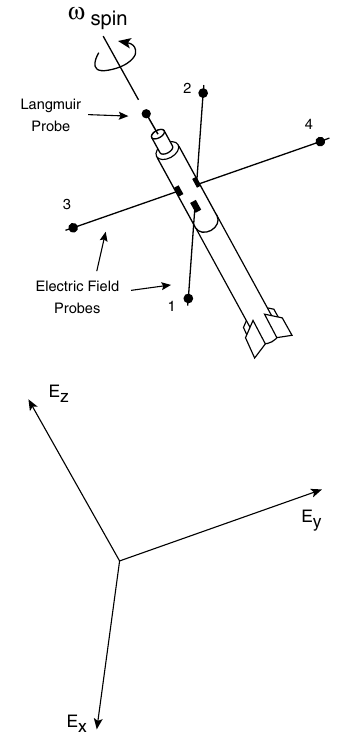
Fig. 2. Payload measurement geometry and associated coordinate system.